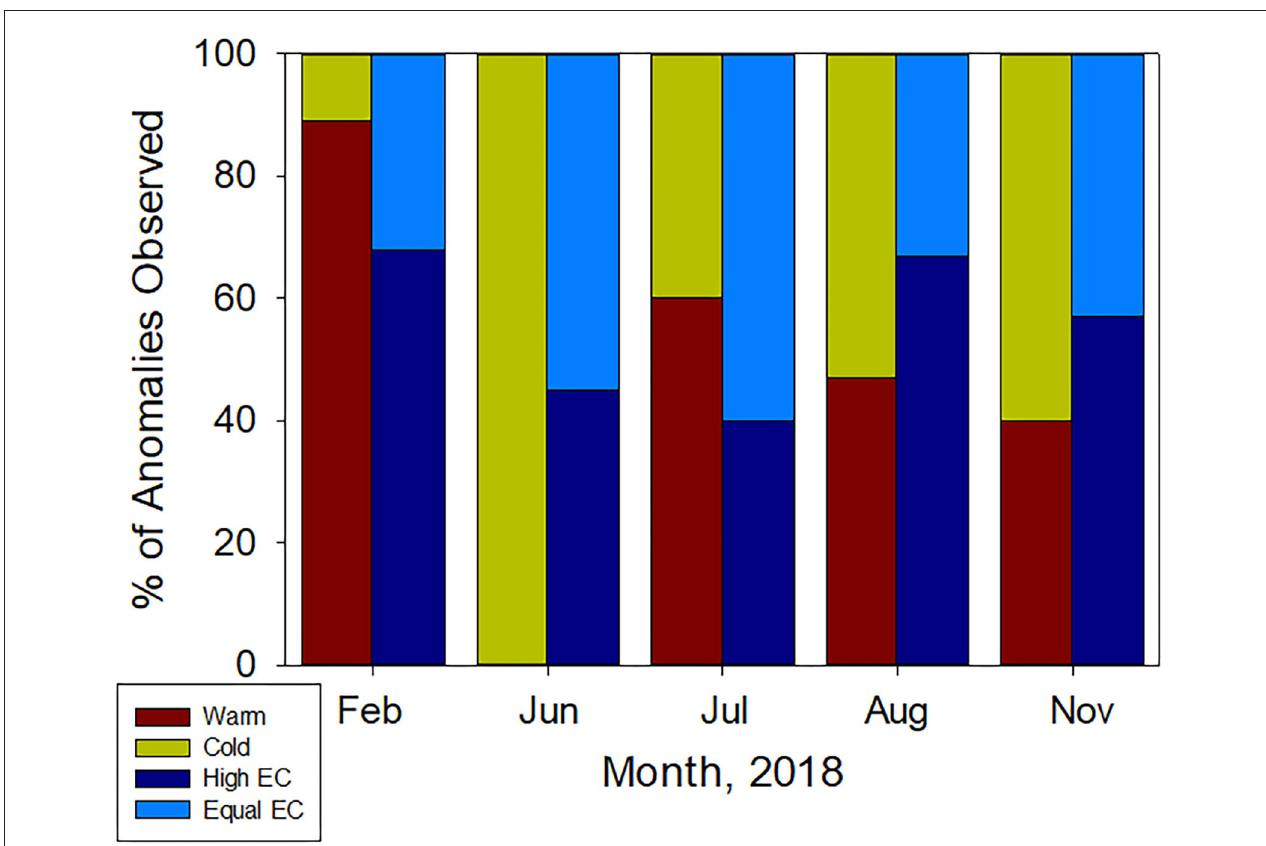
FIGURE 7 | Relative proportion of anomalies by month of field campaigns in